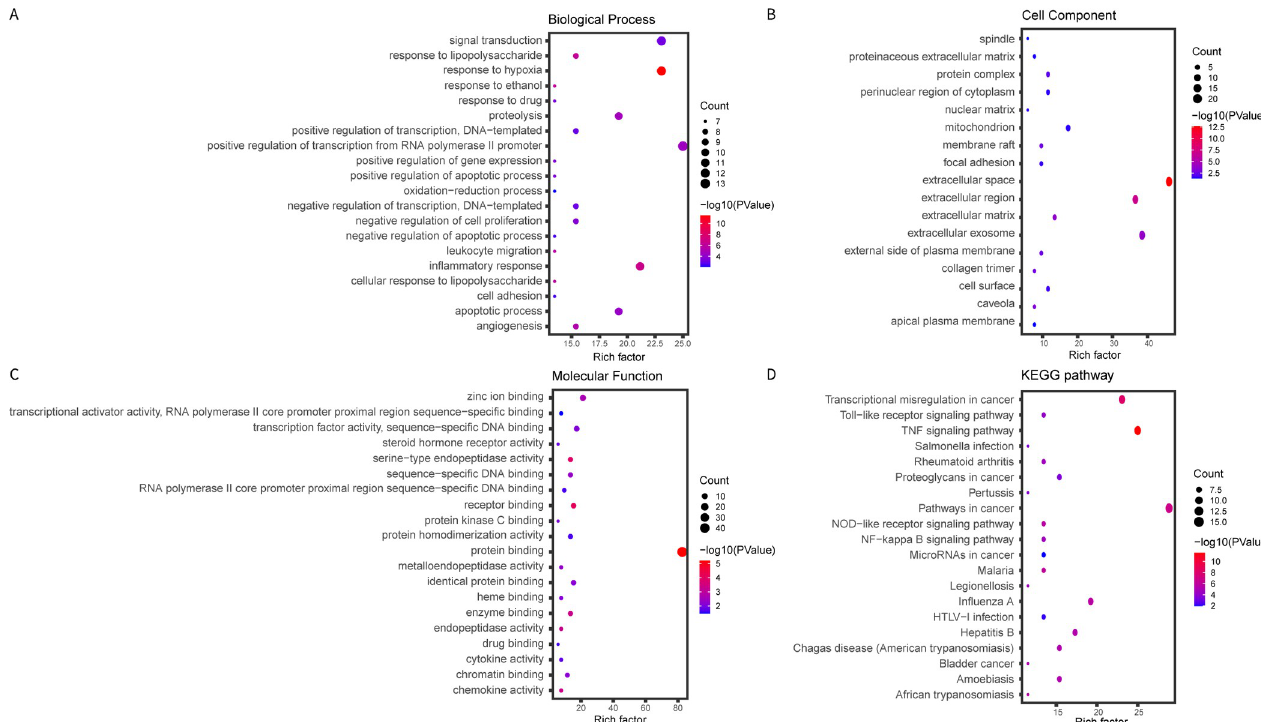
Fig 5. GO (BP, MF, CC) enrichment analysis and KEGG pathway enrichment analysis of 52 nodes.